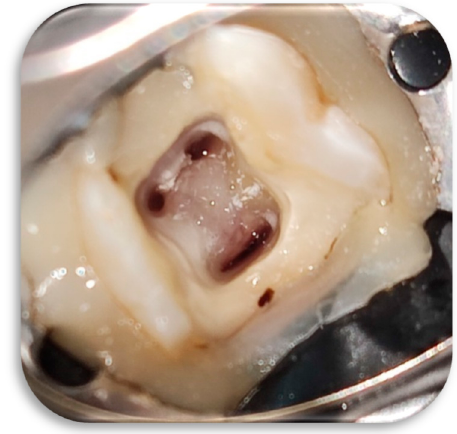
Figure 1. Pulp chamber after caries removed and access cavity refined.